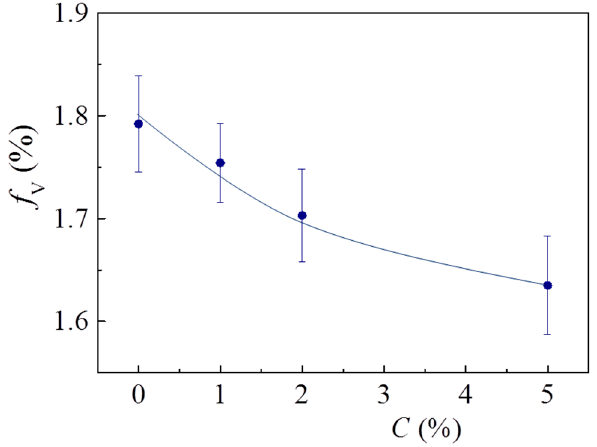
Figure 17. Concentration dependence of the free volume for MLG–epoxy composites.